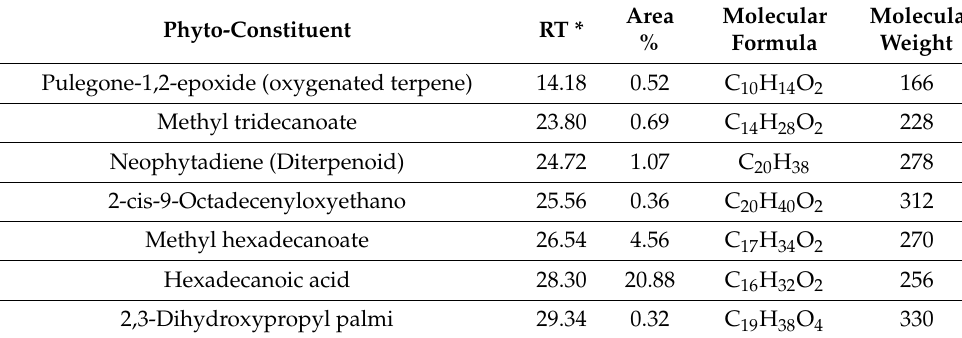
Figure 4. HPLC chromatogram of flavonoids of M. pulegium extract. Table 1. Phyto-constituents of M. pulegium extract identified by